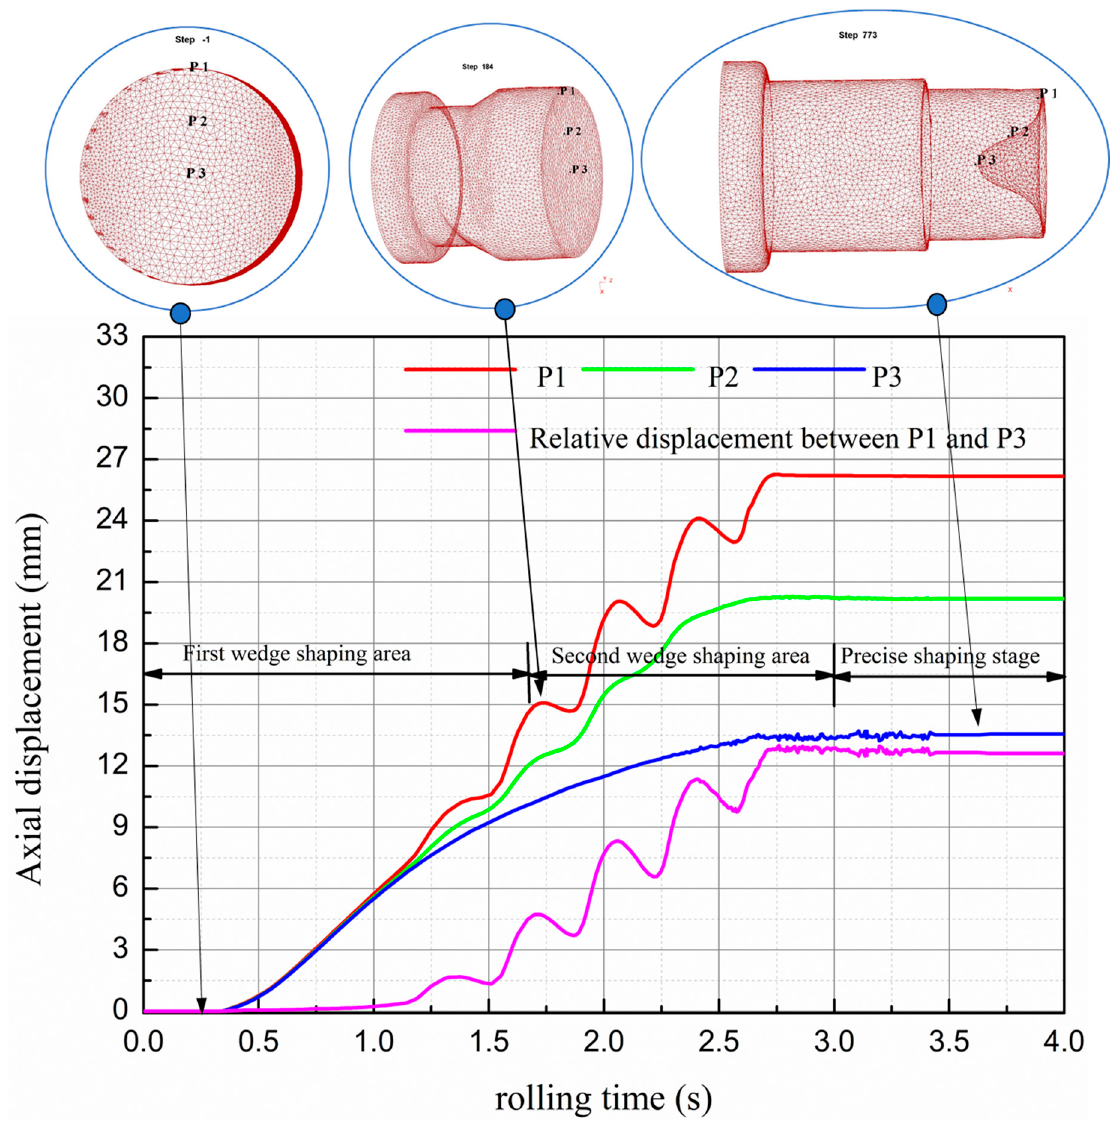
Figure 6. Process of forming of end concaves of stepped shaft based on the point tracing method.